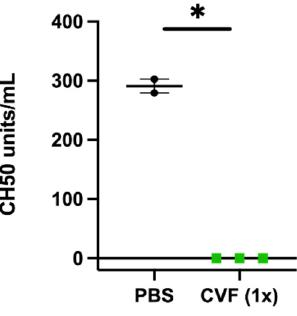
Figure 1. Single-dose application of 12.5 µg of the cobra venom factor (CVF (1x)) leads to the loss of hemolytic complement activity of the serum 24 h after injection. The scatter plot represents the results of a CH50 assay. Data are the means ± S.E.M., n = 3 for the CVF-treated group, n = 2 for the PBS-treated control group, * p < 0.05 (PBS vs. CVF (1x)) by an unpaired Student’s t -test.